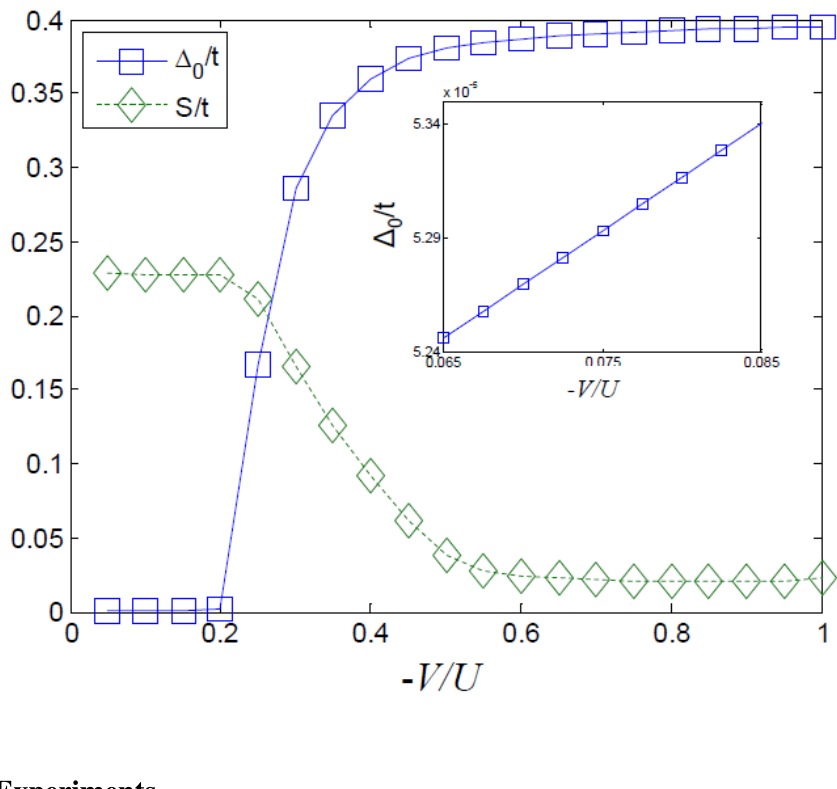
Figure 2. The mean field result for d-wave superconductivity order parameter (squares) and Ne´el order (diamonds) as a function of the ratio between the off-site interaction V and the on-site interaction U . The inset shows a zoom-in on the relevant interaction ratio for the superconducting order parameter ∆ 0